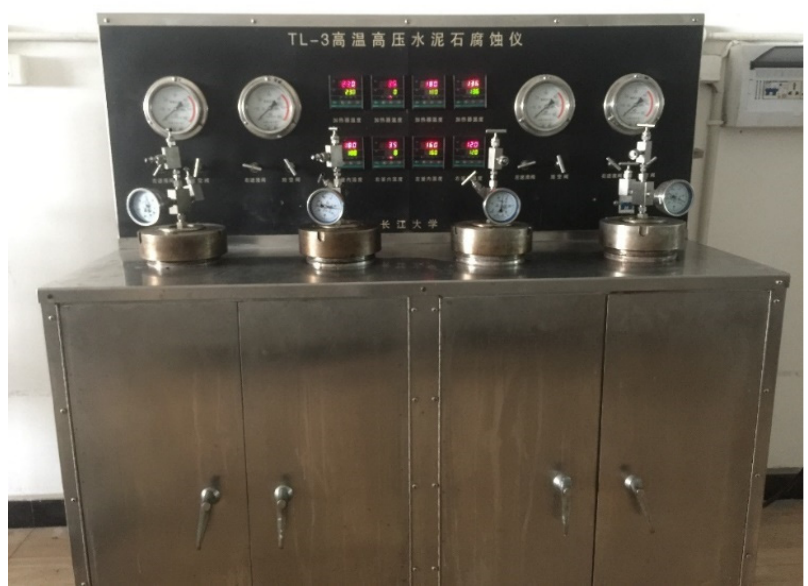
Figure 1. Photo of high-temperature and high-pressure corrosion tester.